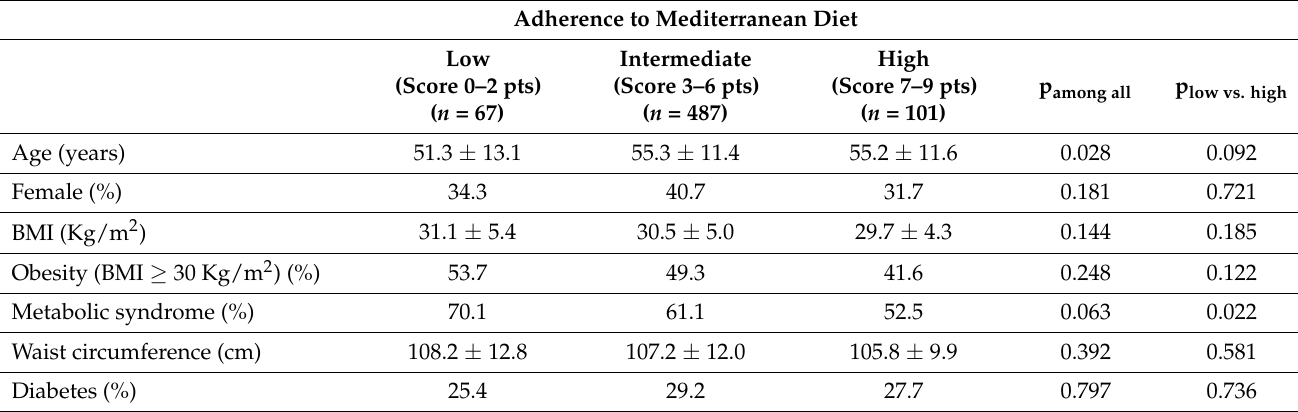
Table 1. Patients’ characteristics according to the adherence to Mediterranean